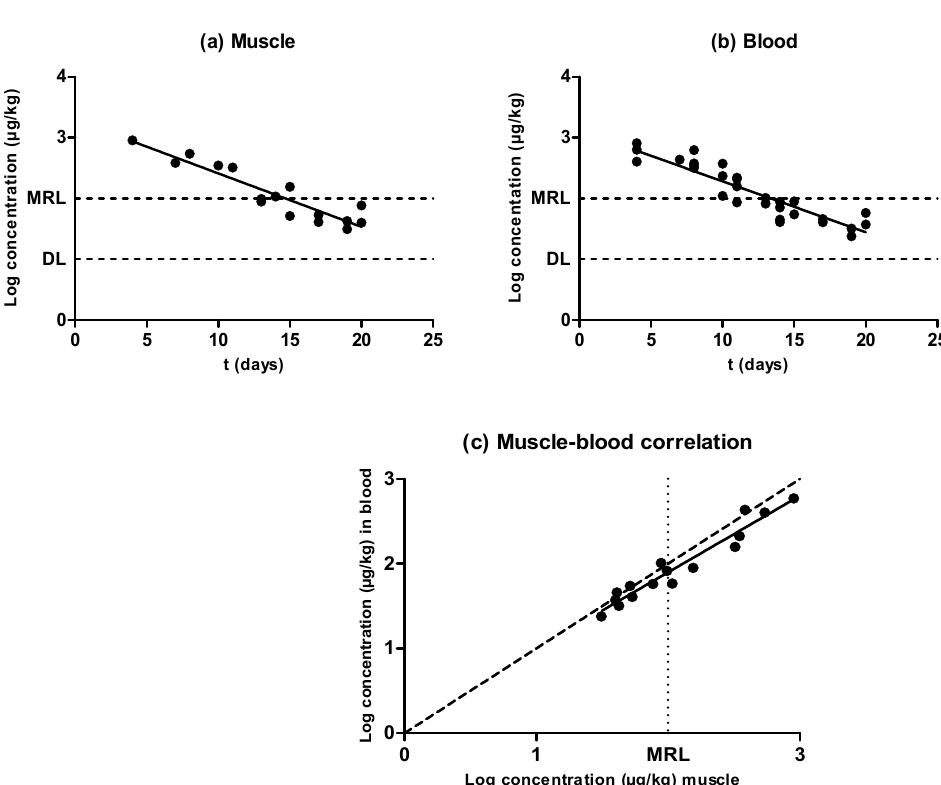
Figure 1. Evolution of the concentration of oxytetracycline in muscle ( a ) and blood ( b ) samples obtained from pigs treated with oxytetracycline and slaughtered at preset intervals within the withdrawal period, determined by liquid chromatography with tandem mass spectrometry (LC–MS / MS). The DL dotted line represents the detection limit of the analytical technique for oxytetracycline, and the maximum residue limit (MRL) dotted line represents the maximum residue limit of oxytetracycline in muscle, as established by Regulation (European Economic Community (EEC)) No. 2377 / 90. Relationship among the concentrations of oxytetracycline detected in blood and muscle samples ( c ). The bisecting dotted line represents the 1:1 correlation if both matrixes contained the same concentration of